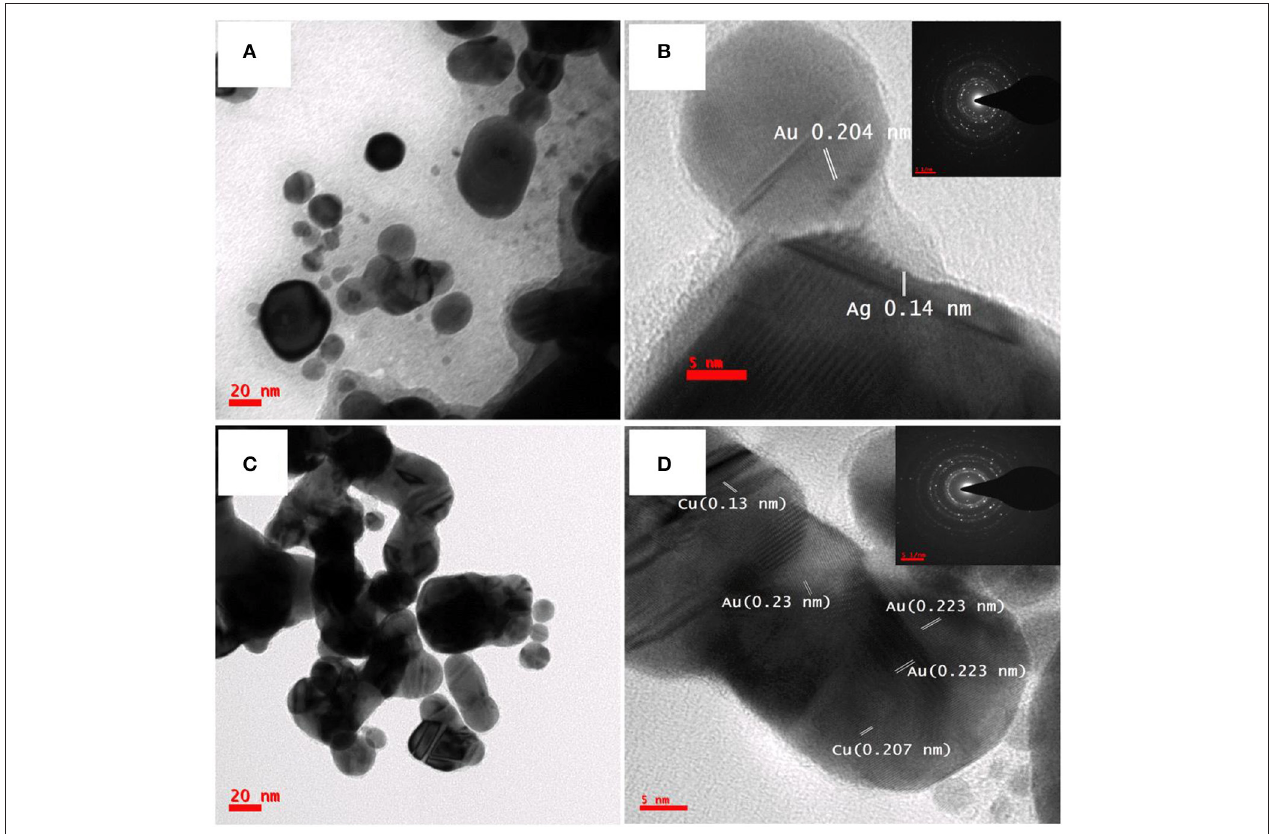
FIGURE 3 | Low and high magnification TEM images of (A,B) Ag @Au NPs (C,D) Cu @Au NPs fabricated by laser ablation of Ag/Cu target in HAuCl 4